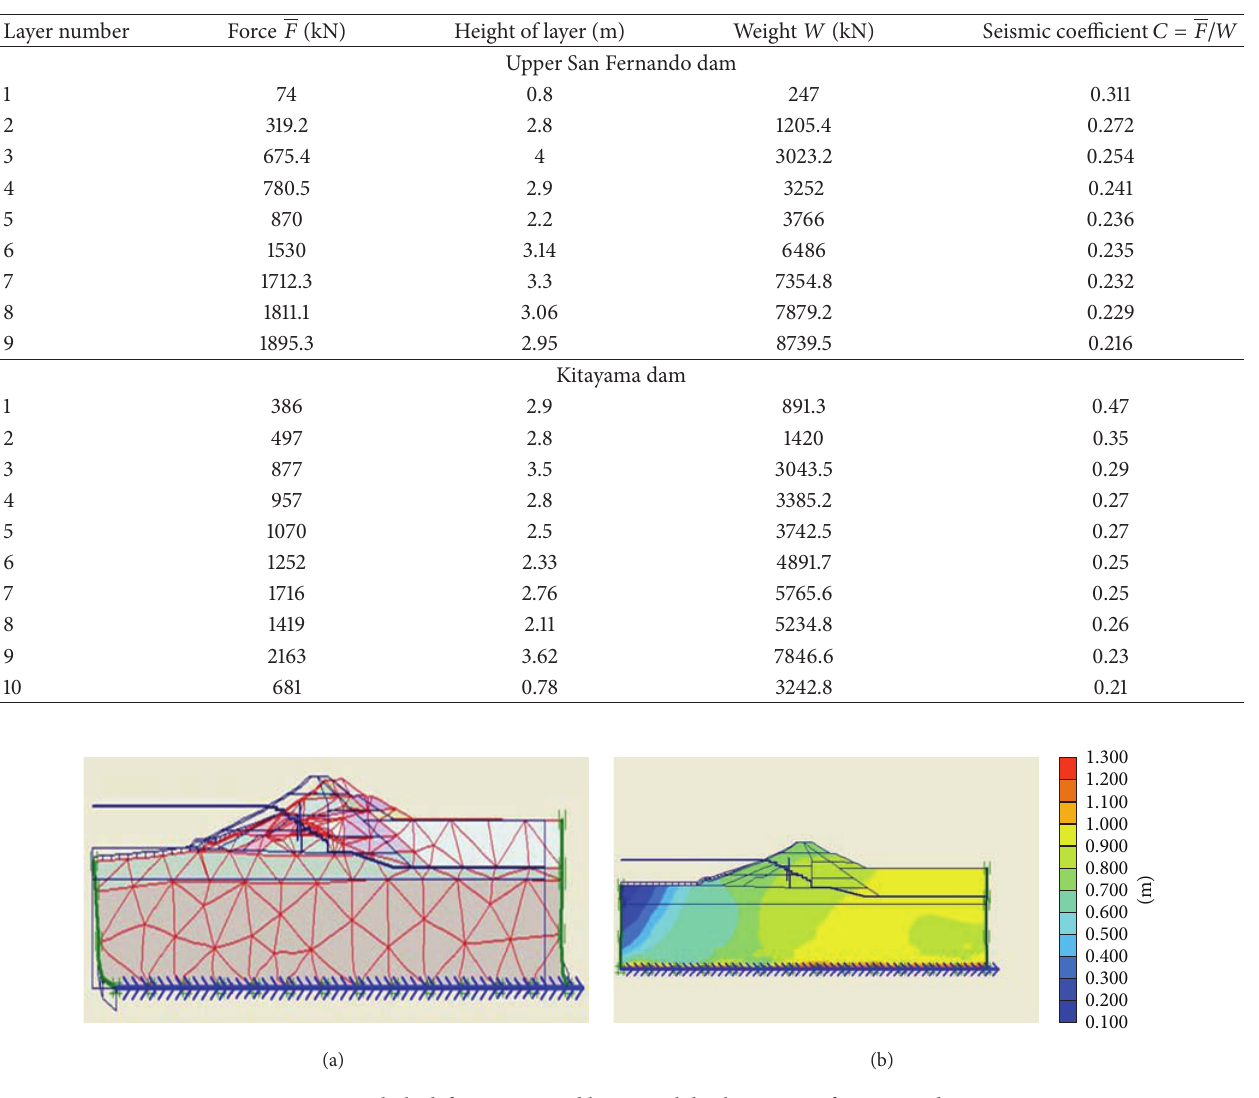
Table 4: Seismic coefficients for Upper San Fernando and Kitayama dams under earthquake loading.